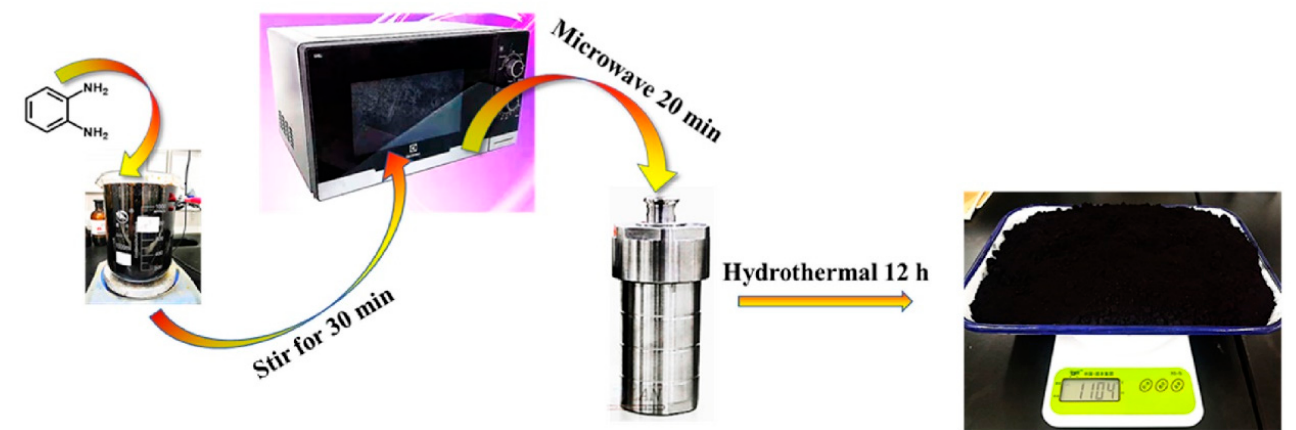
Figure 1. The synthesis process of C-dots 606 from o -PDA at a kilogram scale (1.104 kg) with high yield by a combined microwave-hydrothermal process (reprinted with permission from [50], 2022, Elsevier).